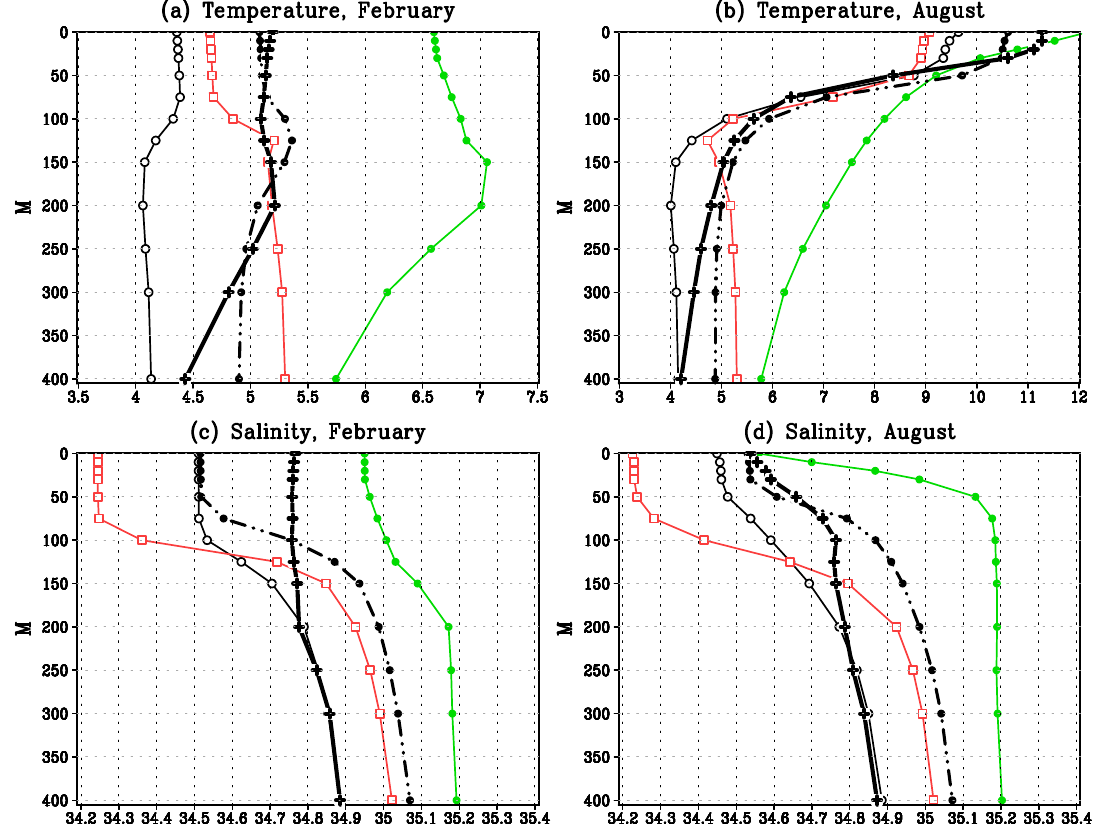
Figure 4. T (in ◦ C) and S (in PSU) profiles for February and August averaged for 1980–2009 in the North Atlantic Current (center of the one-degree model cell near 52 ◦ N, 38 ◦ W): the columns are February ( left ) and August ( right ), rows are temperature ( top ) and salinity ( bottom ). Black solid thick line with crosses represents the climate; Green solid line with dark circles—EX1; Black dash/double dot line with dark circles—EX2; Black solid thin line with hollow circles—EX3; Red solid line with hollow